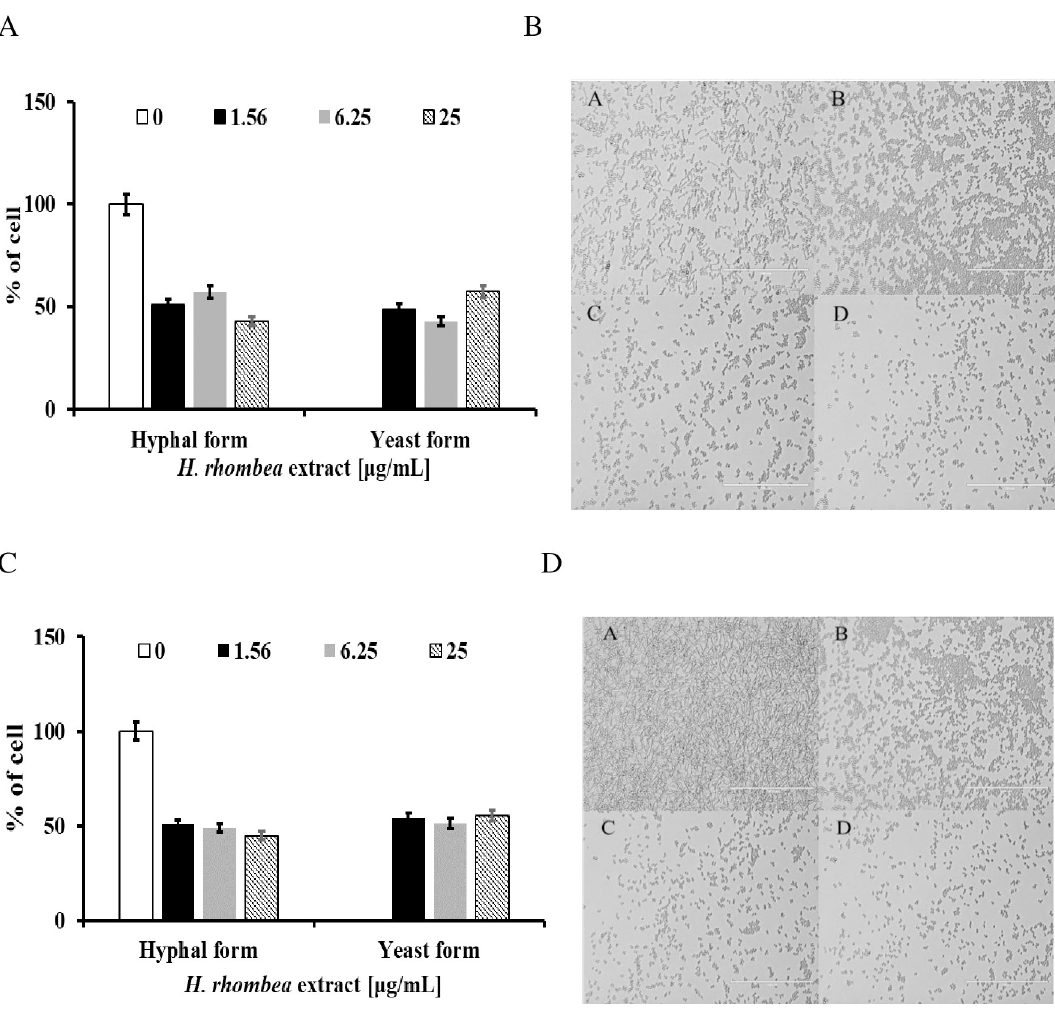
Fig 3. Inhibition of C . albicans dimorphic transition by H . rhombea extract in different hyphal-inducing media. (A) C . albicans dimorphic transition was induced using RPMI 1640 and images of C . albicans cells (B) were obtained using a microscope. A: C . albicans without extract, B: C . albicans with 1.56 μ g/mL of extract treated, C: C . albicans with 6.25 μ g/mL of extract treated, D: C . albicans with 25 μ g/mL of extract treated. (C) C . albicans dimorphic transition was induced using 10% FBS YPD medium and images of C . albicans cells (D) were obtained using a microscope. A: C . albicans without extract, B: C . albicans with 1.56 μ g/mL of extract treated, C: C . albicans with 6.25 μ g/mL of extract treated, D: C . albicans with 25 μ g/mL of extract